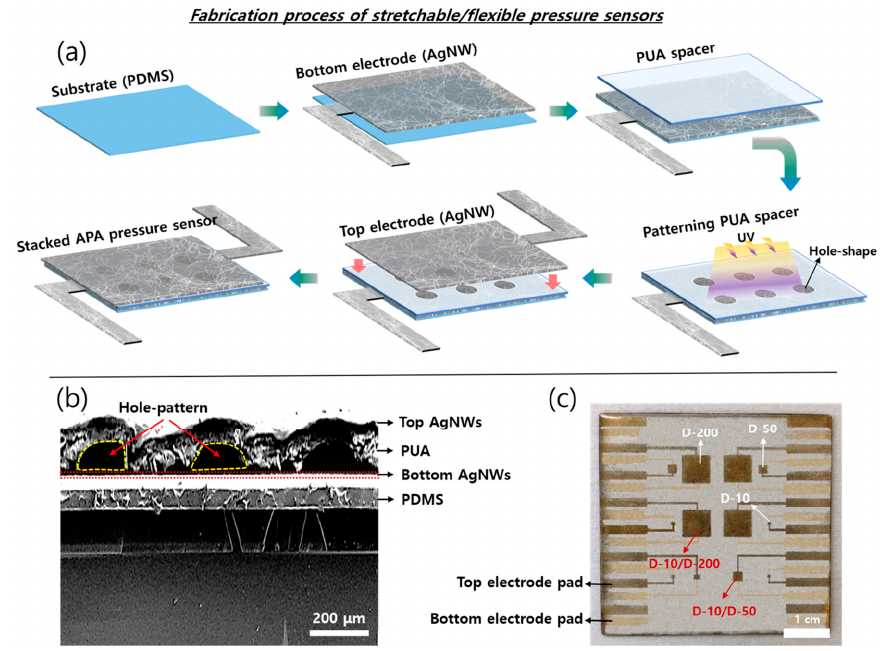
Figure 1. The schematic of the fabrication process and structure of the stretchable sensor. ( a ) A schematic of fabrication process of controllable and stretchable pressure sensor. ( b ) The scanning electron microscopy (SEM) image of the cross-section view of the patterned hole sensor layer. The sensor comprises two stretchable silver nanowire (AgNW)-layers as top and bottom electrodes, polyurethaneacrylate (PUA)-layers as a sensing pattern and insulation layer, and polydimethysiloxane (PDMS) as a bottom substrate and moulding. ( c ) A photograph of the stacked AgNW/PUA/AgNW (APA) piezoresistive type stretchable pressure sensor.